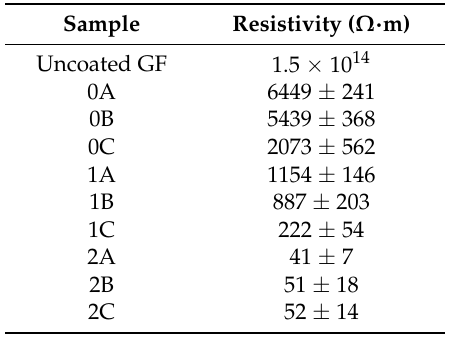
Table 2. Electrical volume resistivity of the treated